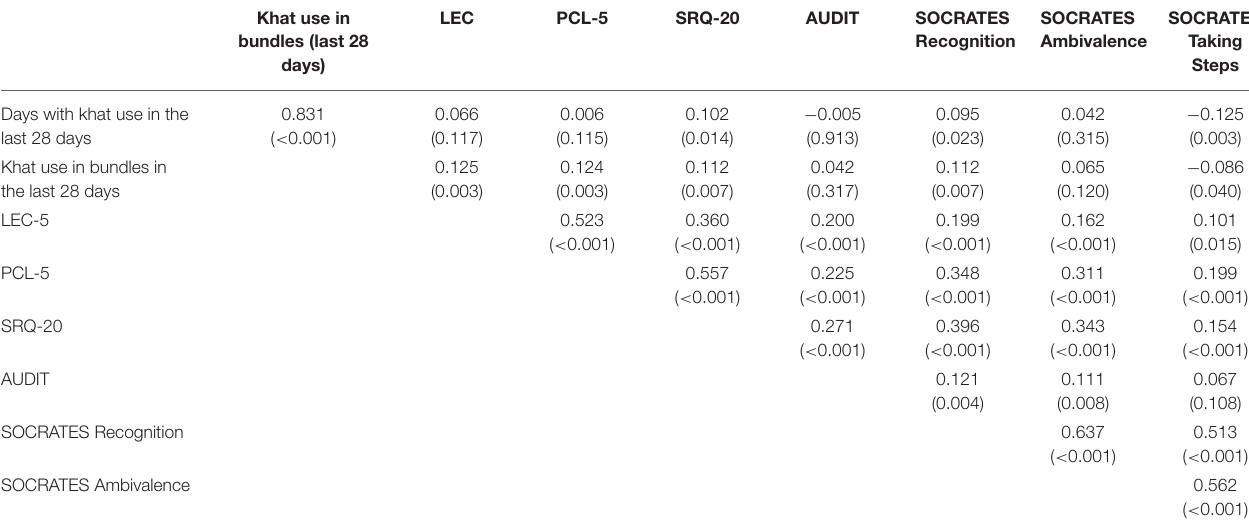
TABLE 1 | Bivariate Spearman rank-order correlations ( p -values in parentheses) in 575 khat-using Jimma University students between days of khat use, khat use in bundles, trauma load (LEC sum score), PCL-5 sum score, SRQ-20 sum score, AUDIT sum score, and SOCRATES subscales. LEC PCL-5 SRQ-20 Khat use in bundles (last 28 days)